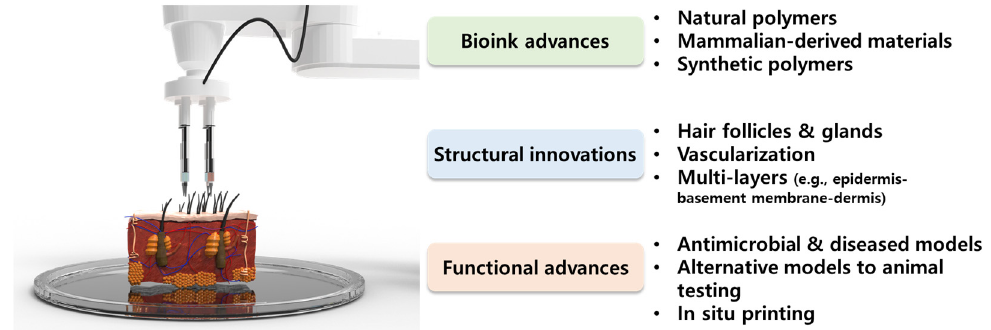
Figure 1. Schematic diagram of recent advances and innovations of bioink materials as well as the structure and function of three-dimensional (3D) bioprinting skin.